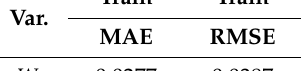
Table 7. Results with the predicted error criteria and the regression model: training analyses.